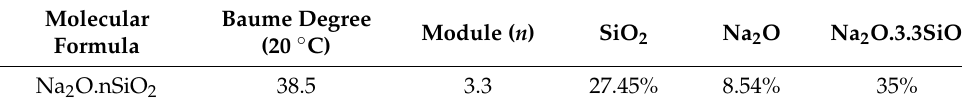
Table 5. Parameters and compositions of